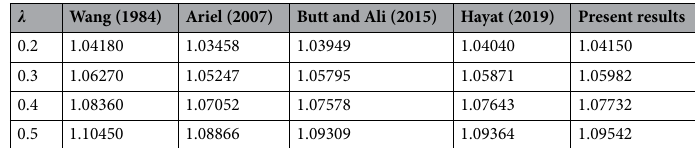
Wang (1984) Ariel (2007) Butt and Ali (2015) Hayat (2019) Present